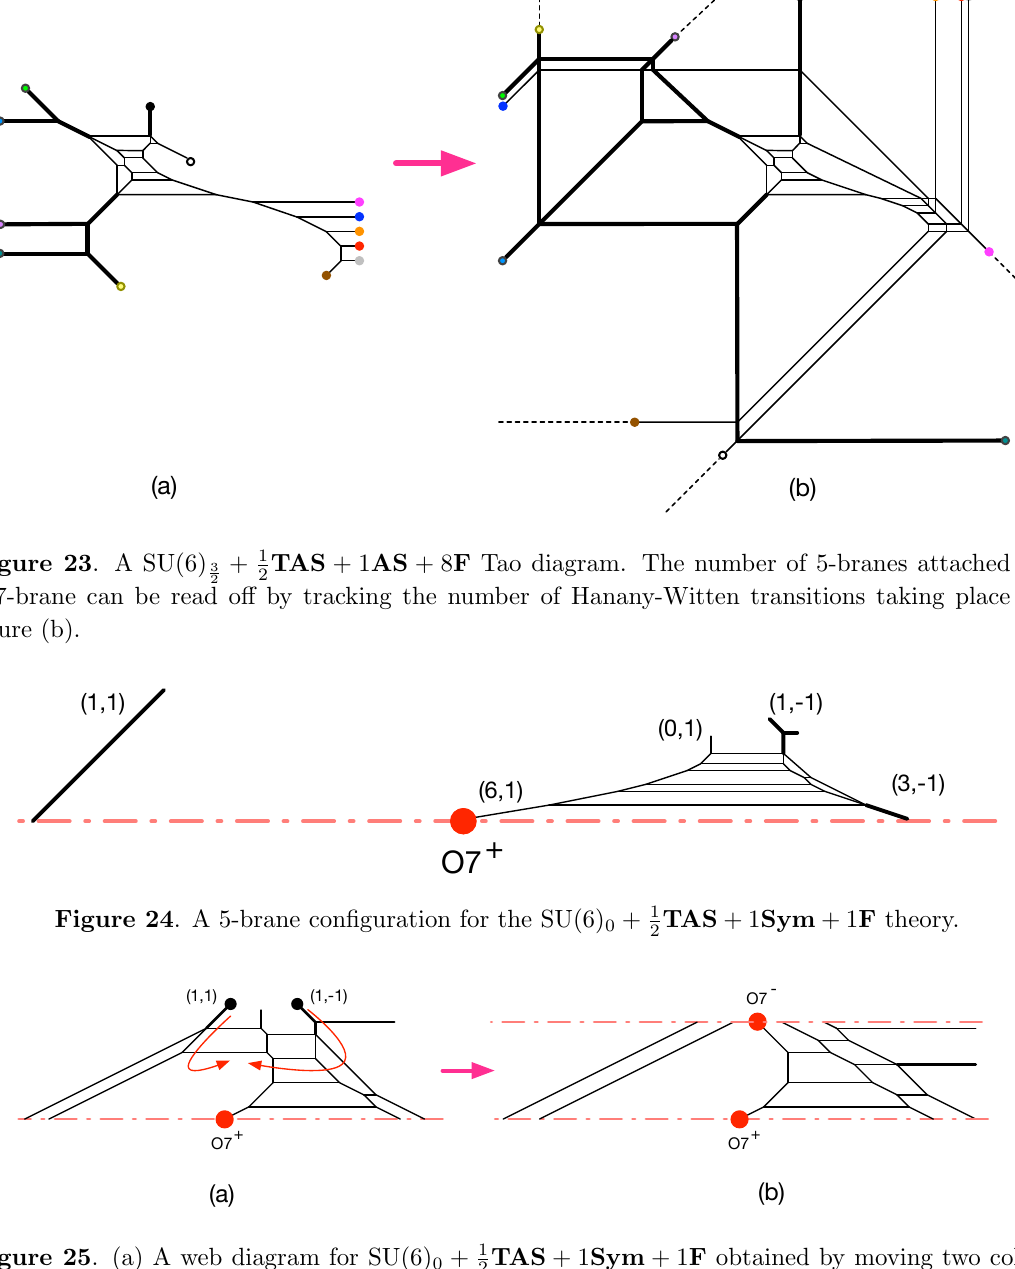
TAS + 1 Sym + 1 F obtained by moving two color 2 TAS +1 Sym +1 F web diagram with both 2